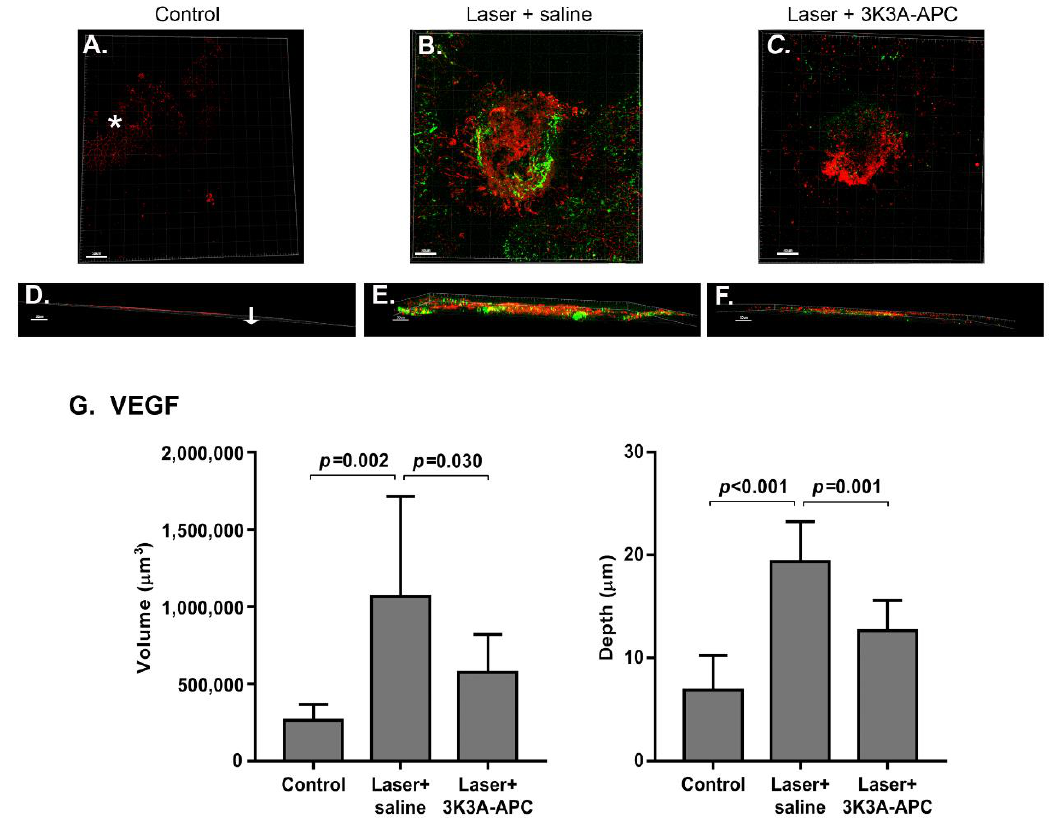
Figure 4. 3K3A-APC reduced VEGF levels. Immediately following laser applications, mice were treated with 1 µ g/ µ L 3K3A-APC or saline. Mice without laser applications served as a control. Three days later, CNV was stained using fluorescein isothiocyanate (FITC)-dextran perfusion, and flat retinal pigmented epithelium (RPE)-choroid specimens were isolated and stained with anti-VEGF antibodies. An immunofluorescent image of RPE-choroid flatmounts average laser- induced CNV spot size, upper view ( A – C ), and Z-plane ( D – F ). Scale bar represents 50 µm and 30 µm for upper view and Z-plane, respectively. The arrow shows the Z-plane (depth), and the asterisk indicates VEGF hexagonal staining of the RPE membrane. Red, VEGF; green, CNV. ( G ) A quantification of the volume (µm 3 ) and the depth (µm) of VEGF in eyes without laser application (control) and eyes subjected to laser and treated with either saline (laser + saline) or with 3K3A- APC (laser + 3K3A-APC). The data are presented as mean ± SD (7 – 9 mice per group) and were analyzed using one-way ANOVA followed by Tukey post hoc test. 4. Discussion In the current study, we elaborate on the data regarding APC use as a potential treat- ment for CNV. We previously demonstrated that APC has the ability to inhibit the growth of newly formed CNV, inhibit pathological leakage from CNV, and tighten the oBRB. Moreover, we showed that APC ’ s protective activities in the retina were mediated by the Tie2 receptor [7]. As APC is a natural coagulation inhibitor, bleeding risk may be a major issue. Clinical studies showed that APC therapy increased the risk for serious bleeding events in adult patients with severe sepsis [16,17]. 3K3A-APC is a recombinant engineered variant of APC (three Lys residues replace three Ala residues) with markedly reduced anticoagulant ac- tivity. Although the replacement of the three residues in the 3K3A-APC variant reduces APC ’ s interactions with its substrate, clotting factor Va, it does not affect APC ’ s interac- tions with its cell receptors, including binding to endothelial protein C receptor and acti- vating protease-activated receptors (PAR) 1 and 3. [4,6,18]. Thus, both wild-type APC and